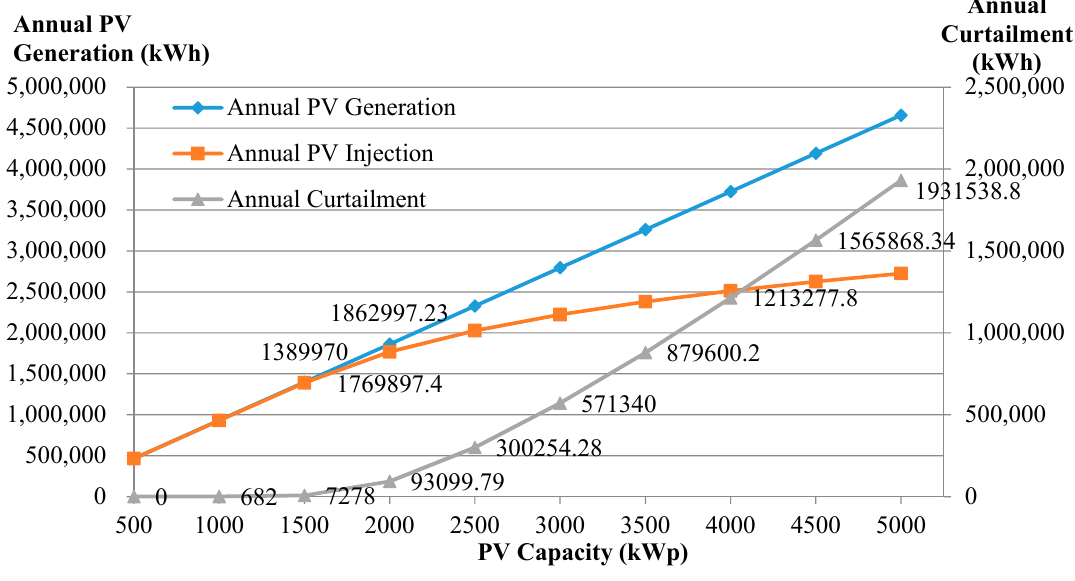
Figure 5. Annual PV generation, injection, and curtailment for different capacities ( pf = 1.0).